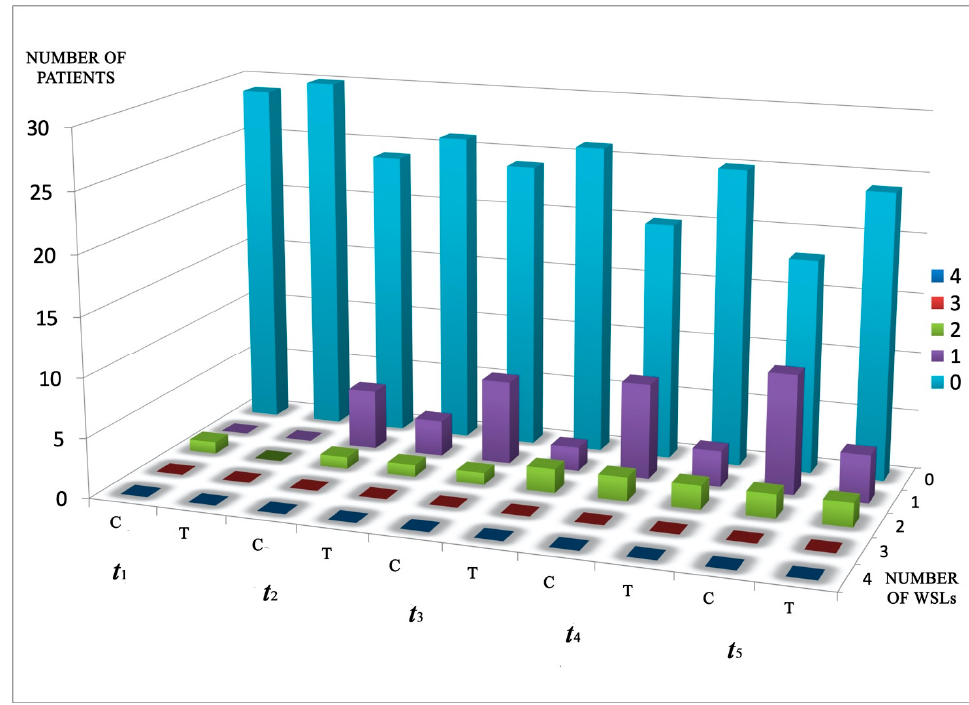
Figure 6. WSLs trend during the study.